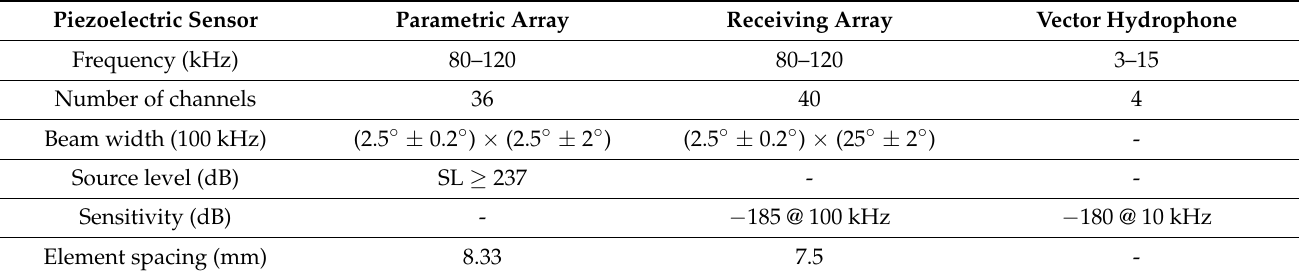
Table 1. Design parameters of the integrated detection sonar transducers.